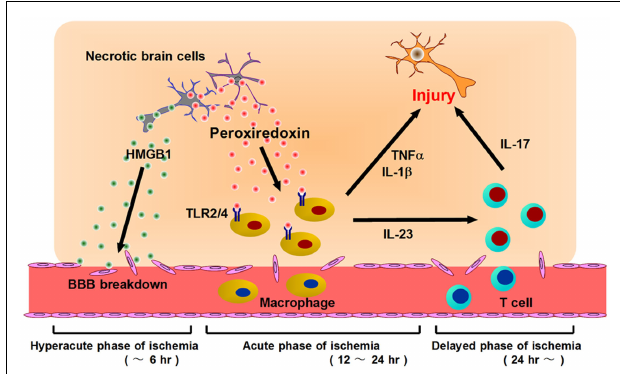
FIGURE 3 | Post-ischemic inflammation triggered by DAMPs and infiltrating immune cells. At the hyperacute phase of brain ischemia (within 6h after stroke onset), HMGB1 is released from brain cells and induces BBB breakdown. Following this, blood cells begin to infiltrate into ischemic brain tissue via disrupted vessels during the acute phase of ischemia (12–24h after stroke onset). Prx is extracellularly released from necrotic brain cells and activates infiltrating macrophages viaTLR2 and TLR4. Activated macrophages produce inflammatory cytokines (IL-23, IL-1 β , TNF- α , etc.) which promote ischemic brain injury. At the delayed phase of brain ischemia (more than 24h after stroke onset), IL-23 induces IL-17 production from γδ T lymphocytes, which further enhances ischemic damage.Thus, HMGB1 is a hyperacute DAMP, while Prx is secondarily active in post-ischemic inflammation, during the acute